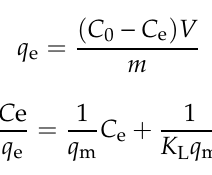
Figure 11. The corresponding Langmuir parameters calculated at room temperature were as